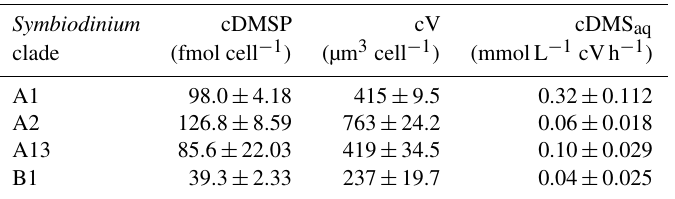
Table 2. Parameters for cellular DMSP concentration (cDMSP), cell volume (cV) and cellular net DMS aq production rate (cDMS aq ) in four clades of Symbiodinium sp. (data from Steinke et al., 2011).